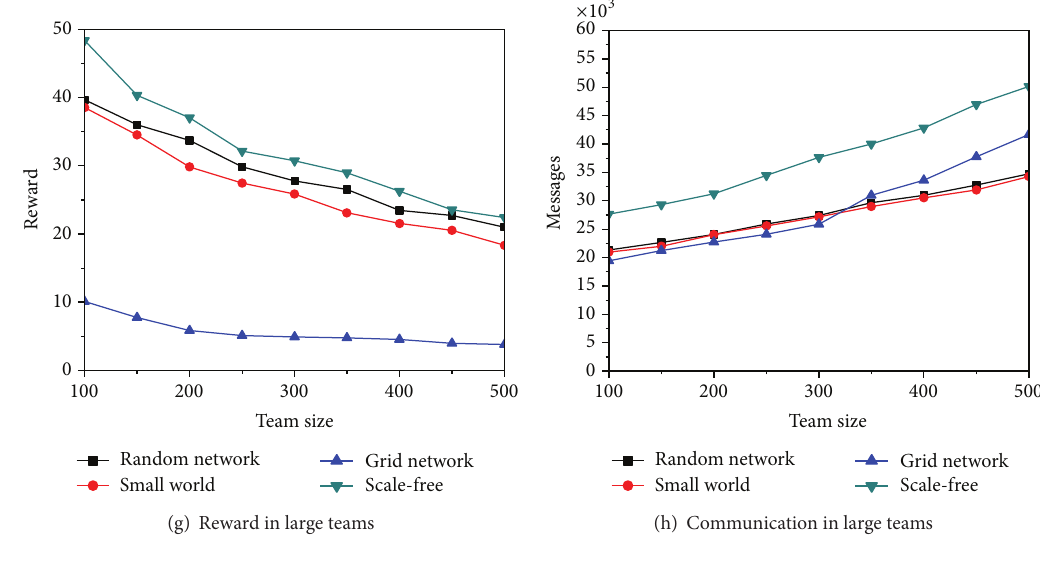
Figure 8: Effects of complex networks on different scale multiagent